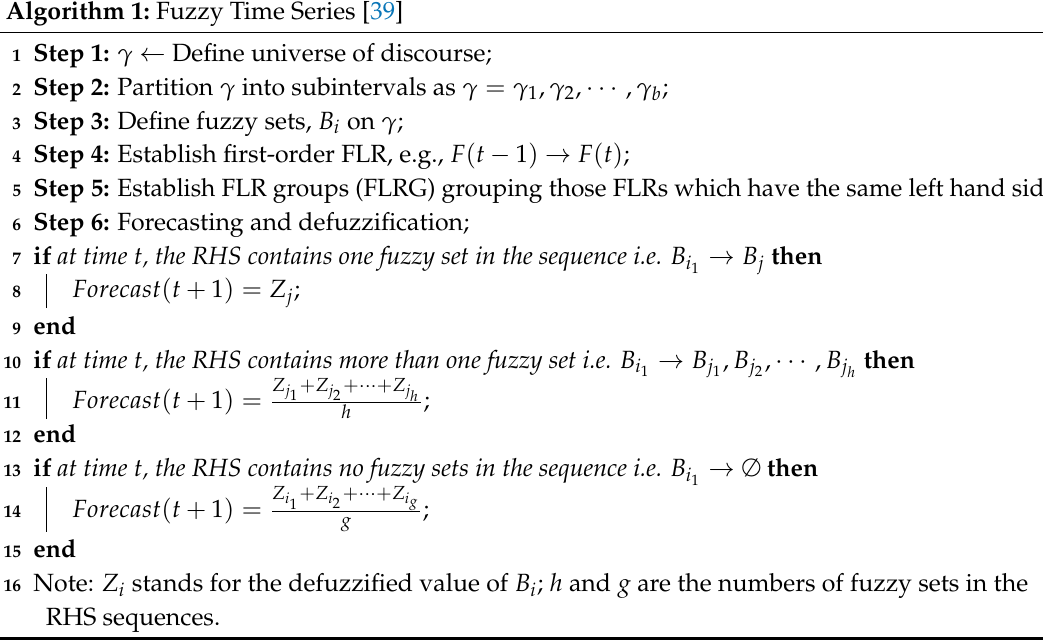
Algorithm 1: Fuzzy Time Series